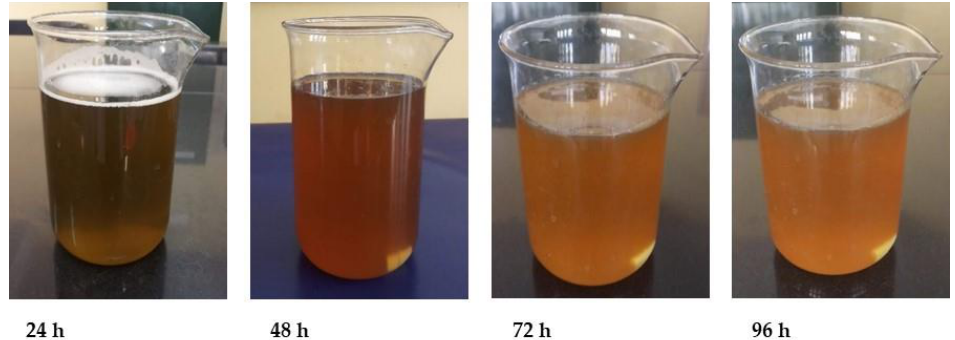
Figure 1. Gradual color change of the TPE-derived ZnO NP solution over time (for 4 days). A progressive shift in the color of the solution from green to yellow indicated the formation of ZnO NPs.